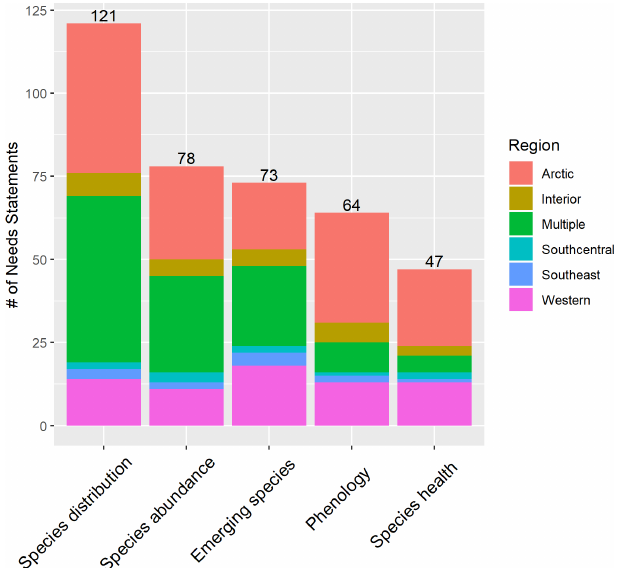
Fig. 3 . Stakeholder information needs related to wild food species